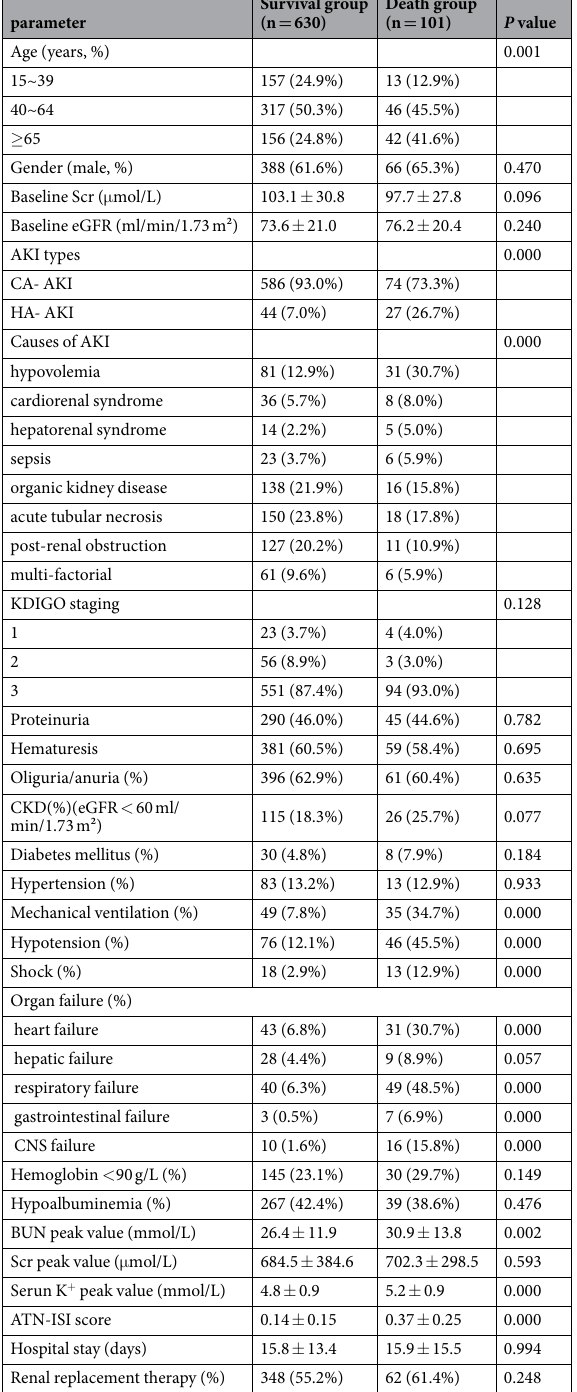
Table 3. Single factor analysis of prognosis within 90 days between the survival group and death group in AKI patients. Abbreviation: AKI: acute kidney injury; Scr: serum creatinine; eGFR: basic estimated glomerular filtration rate; CA-AKI: Community-acquired AKI; HA-AKI: Hospital-acquired AKI; CKD: chronic kidney disease; BUN: Blood urea nitrogen; CNS: central nervous system; ATN-ISI: acute tubular necrosis-individual severity